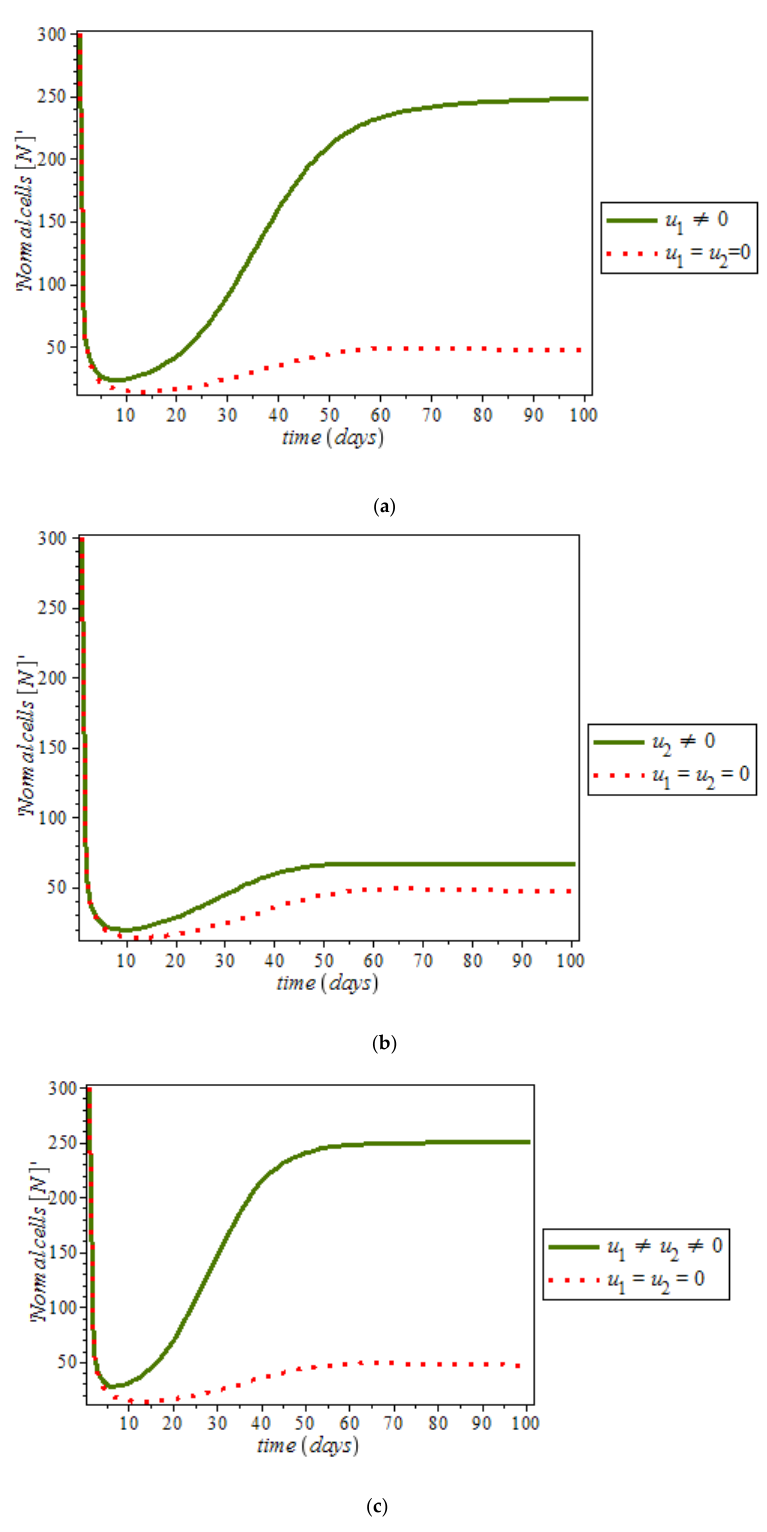
Figure 10. Simulation result of the model (9), showing normal cell population against time with and without